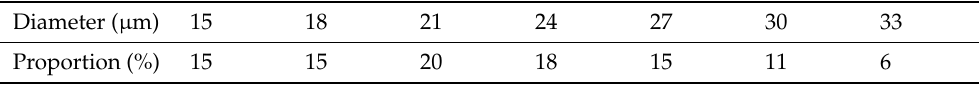
Table 4. Particle size distribution of 316L stainless steel powder